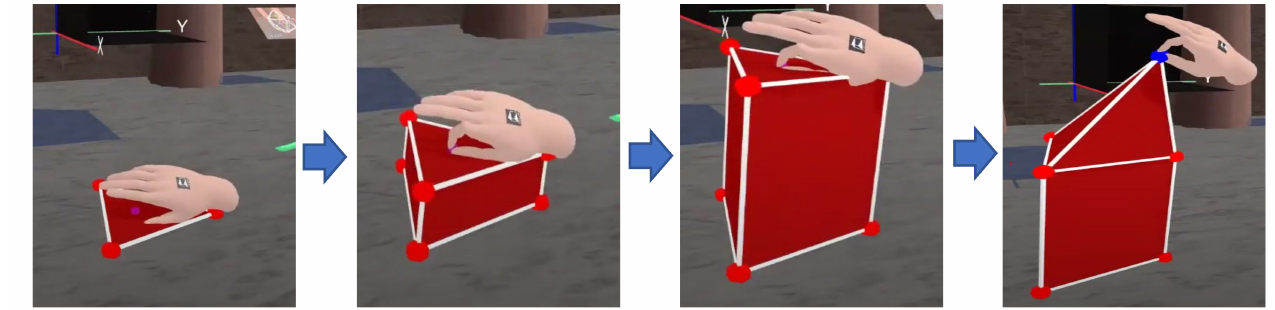
Figure 11. Triangle extrusion to obtain a prism and point extrusion to obtain a pyramid on